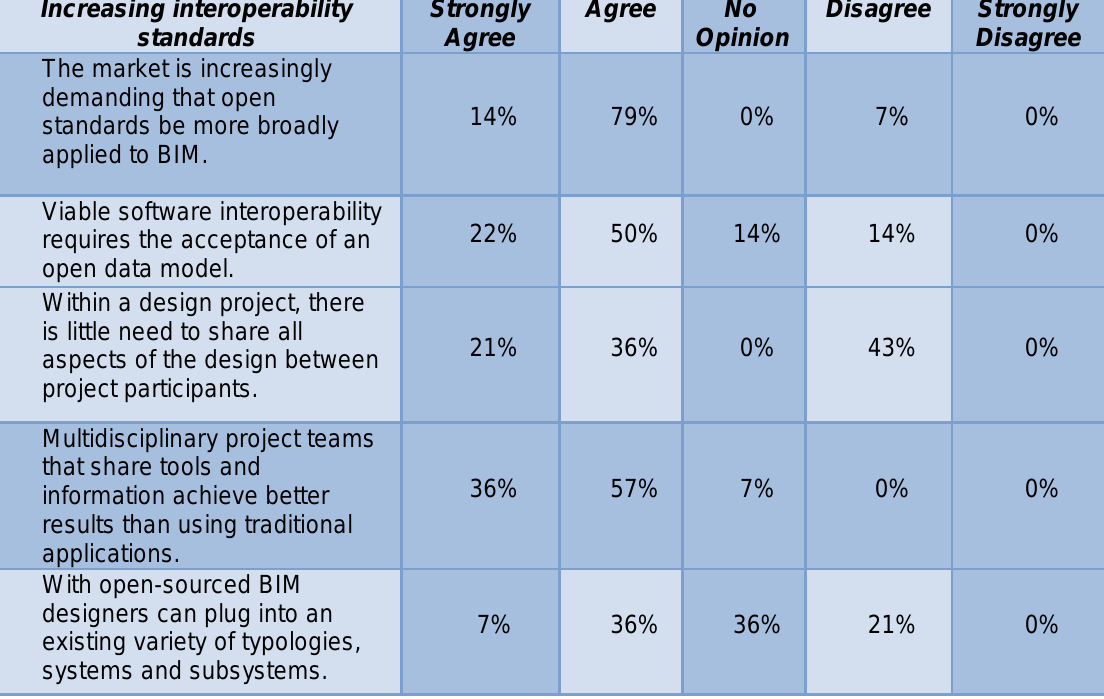
Table 2 Increasing interoperability standards in the BIM